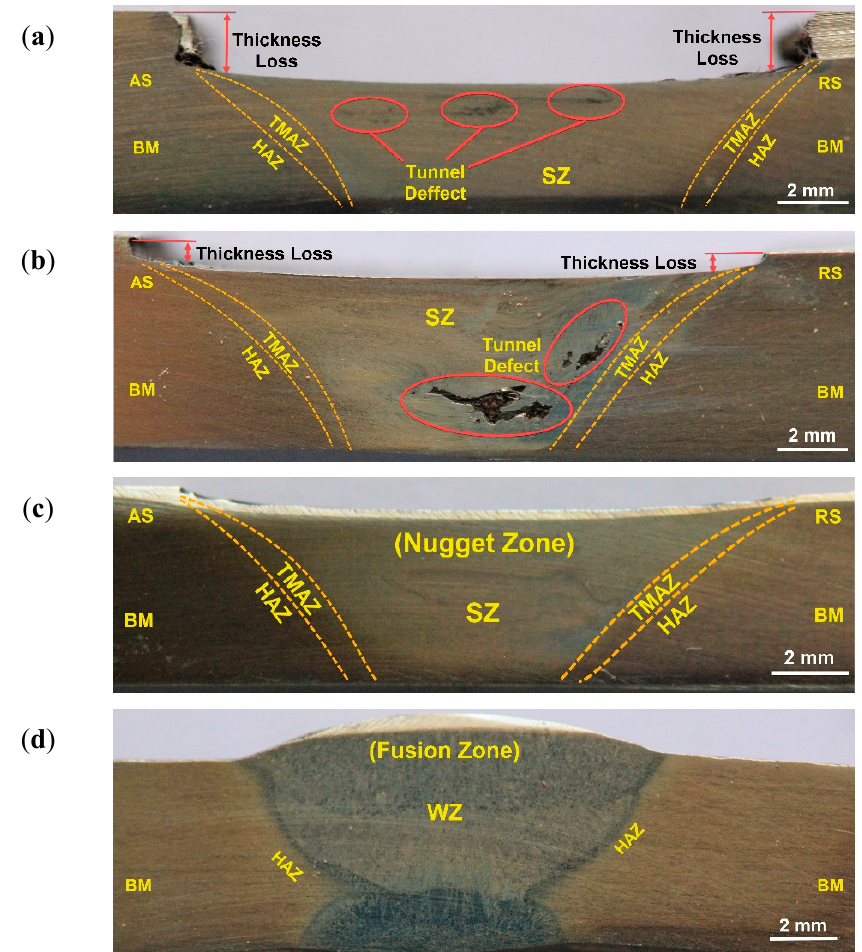
Figure 8. Macrostructure of FSW welds: (a) FSW, U-shaped groove with root; (b) FSW, V-shaped groove without root; (c) FSW, V-shaped groove with root face; and (d) GTAW, V-shaped groove groove without root; ( c ) FSW, V-shaped groove with root face; and ( d ) GTAW, V-shaped groove with with root face and root gap, GTAW weld for 2205 DSS butt joints. root face and root gap, GTAW weld for 2205 DSS butt